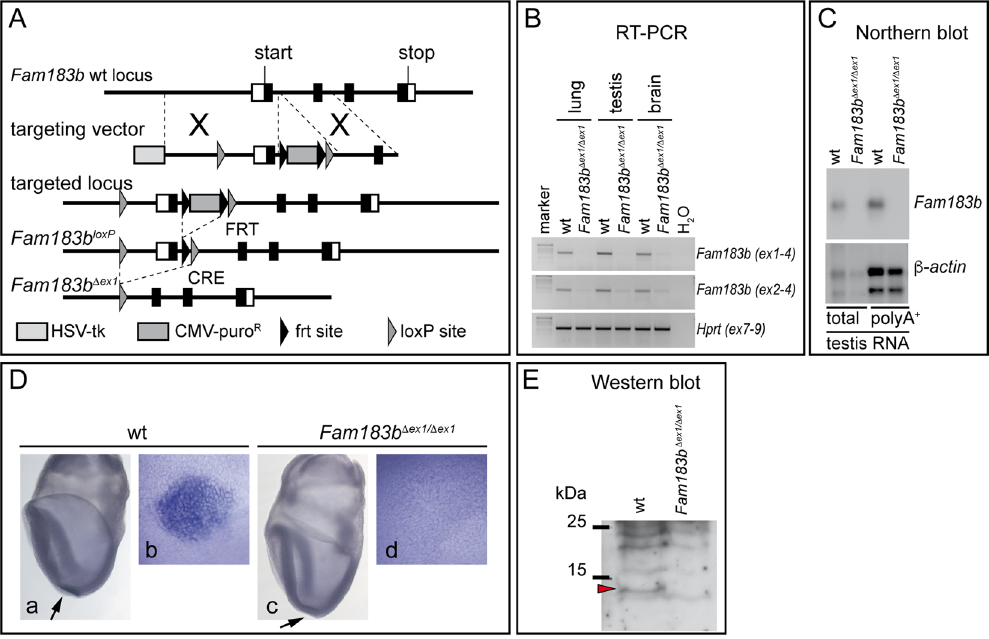
Figure 4. Generation and validation of a Fam183b -null allele. ( A ) Schematic drawing depicting the structure of the wild type locus, targeting vector and mutated allele. ( B ) RT-PCR with primers binding in Fam183b exon 1 and 4, Fam183b exon 2 and 4, and Hprt exon 7 and 9 on RNA from adult tissues. Full size gel is shown in Supplementary Figure S3. ( C ) Northern blot of total and polyA + RNA from wt and Fam183b- mutant testes. Full size Northern blots are shown in Supplementary Figure S4. ( D ) WISH of E7.75 wt (a,b) and Fam183b Δ ex1 / Δ ex1 (c,d) embryos. (b,d) higher magnification of ventral views of the LRO. ( E ) Western blot analysis of testis lysates from wt and Fam183b Δ ex1 / Δ ex1 testes. The full size Western blot is shown in Supplementary Figure